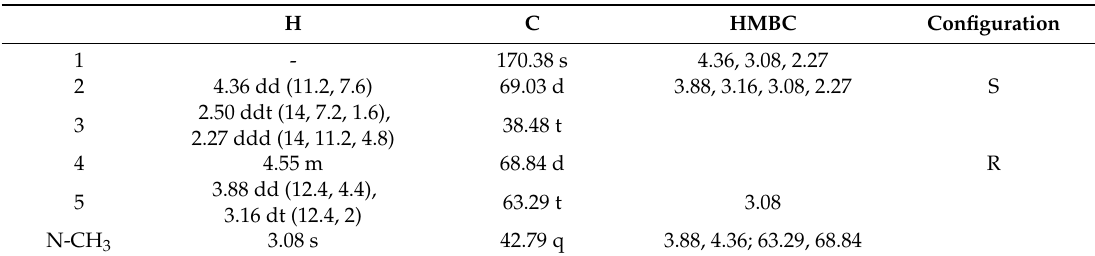
Table 3. 1 H- and 13 C-NMR data of 4-Hydroxy-1-methyl- l -proline (compound I )(400 and 100 MHz, respectively; MeOH-d 4 , δ -values, J in Hz). H C HMBC